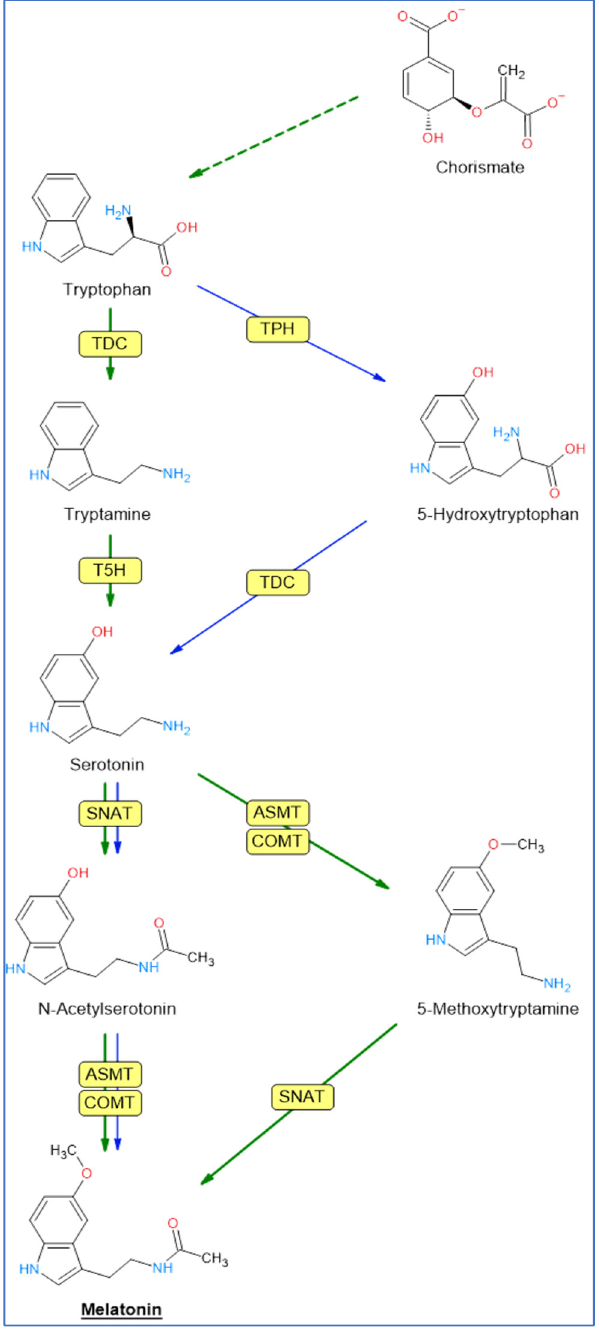
Figure 1. Pathways of melatonin biosynthesis in plants (green arrows) and animals (blue arrows). Enzyme abbreviations: TDC = tryptophan decarboxylase; TPH = tryptophan hydroxylase; T5H = tryptamine 5-hydroxylase; SNAT = serotonin N -acetyltransferase; ASMT = acetylserotonin methyl transferase; COMT = caffeic acid O